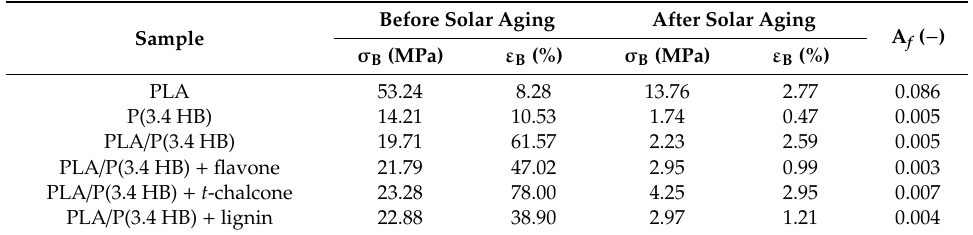
Table 5. The comparison of mechanical properties of tested PLA, P(3.4 HB), and PLA / P(3.4 HB) composites before and after solar